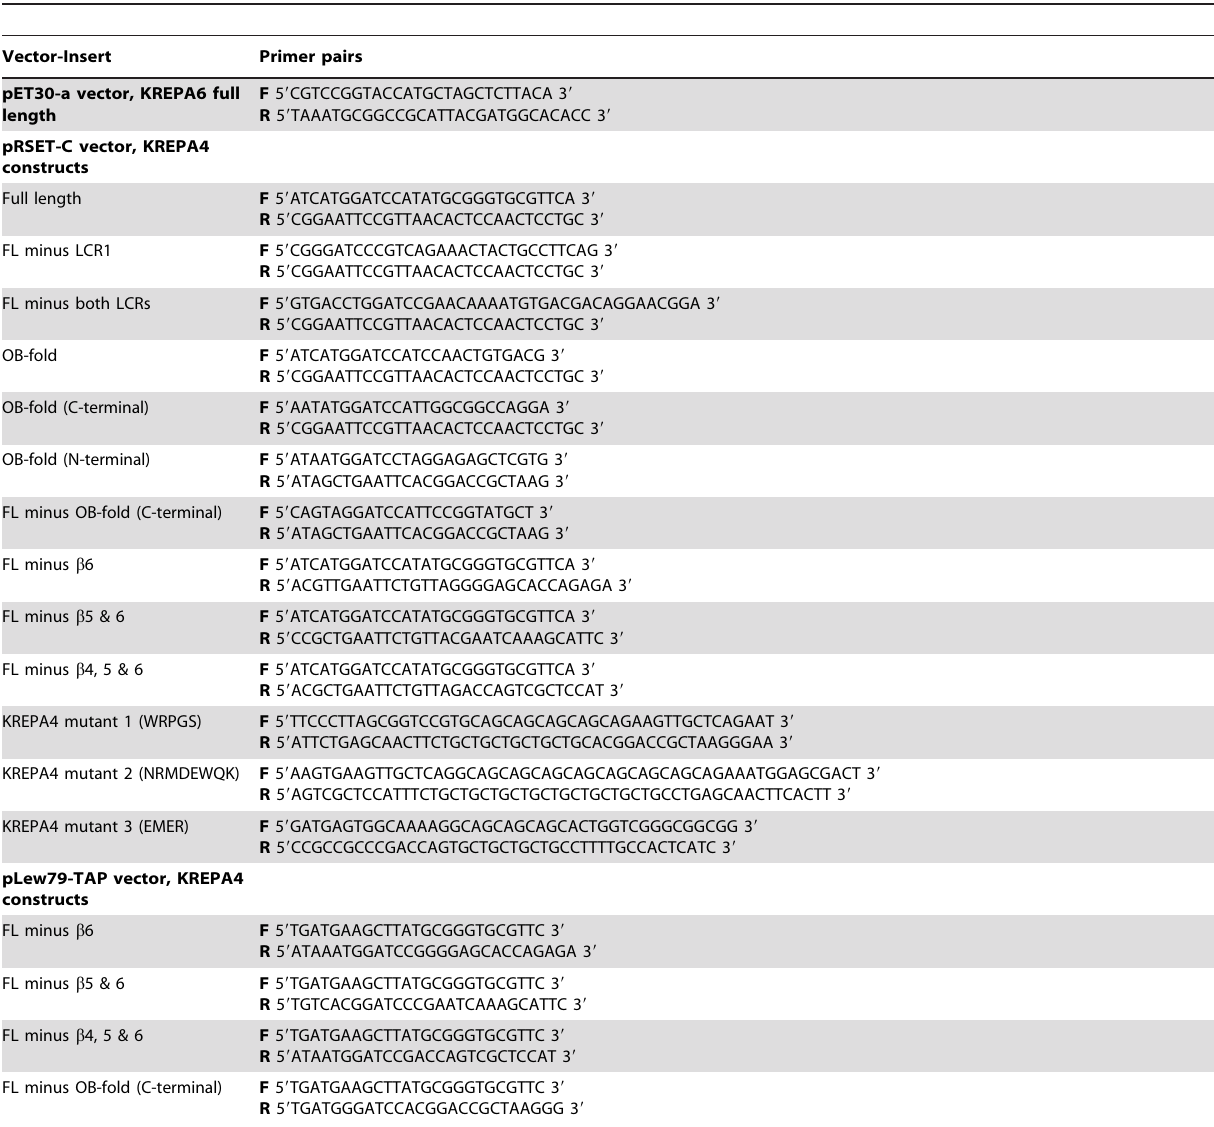
Table 1. Forward (F) and reverse (R) primer pairs used for cloning KREPA6 or KREPA4, full length or deletion variants in the indicated